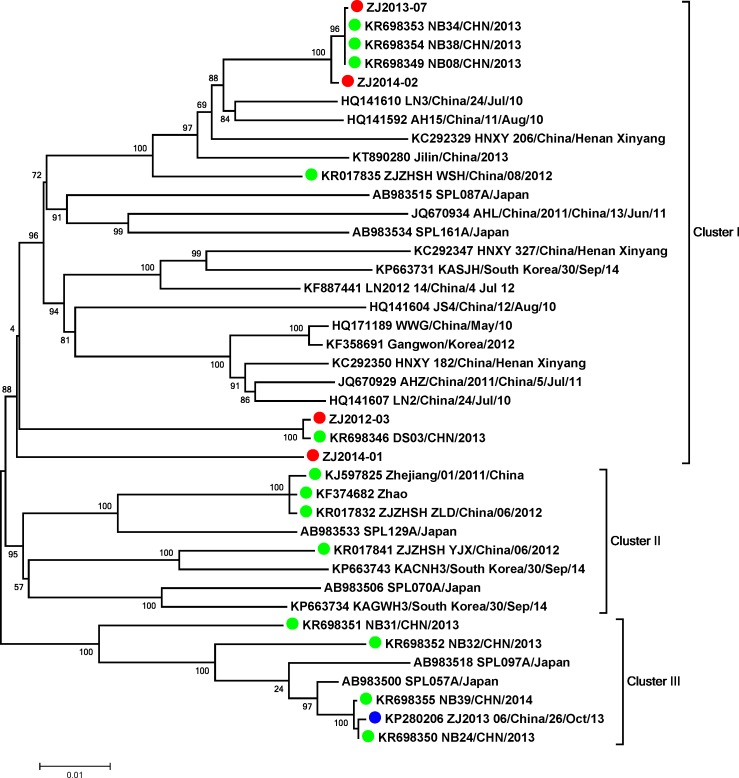
Phylogenic analysis of the whole sequence of the L gene of ZJ2013-06 and other 39 representative SFTSVs.The maximum likelihood (ML) tree was generated using PhyML version 3, with the GTR + Γ nucleotide substitution model and a Subtree Pruning and Regrafting (SPR) topology searching algorithm. SFTSV was divided into three clusters, labeled I, II, and III. Strains marked with red circles represent viruses isolated in Zhejiang and sequenced in this study. Strains marked with green circles represent viruses isolated in Zhejiang and sequenced previously. The strain marked with a blue circle is the ZJ2013-06 strain from the specific case with no fever.